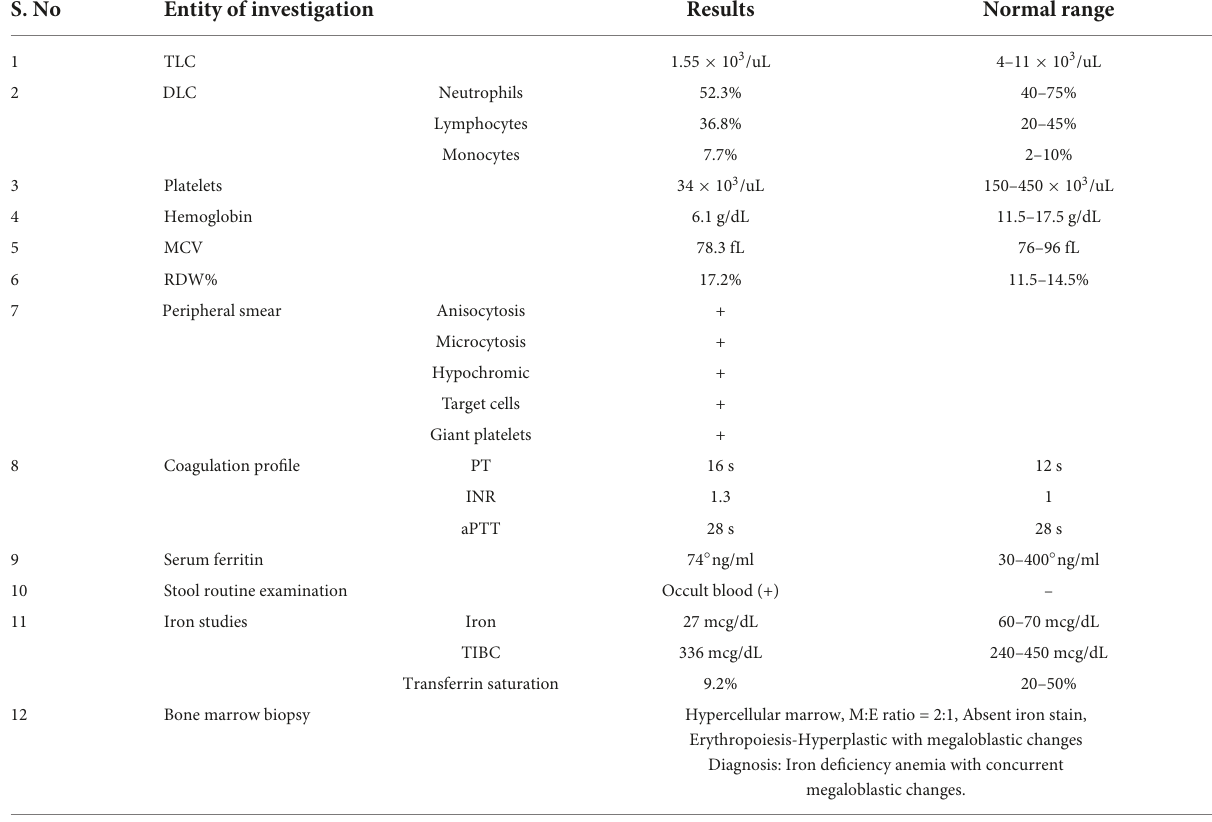
Hypercellular marrow, M:E ratio = 2:1, Absent iron stain, Erythropoiesis-Hyperplastic with megaloblastic changes Diagnosis: Iron deficiency anemia with concurrent megaloblastic